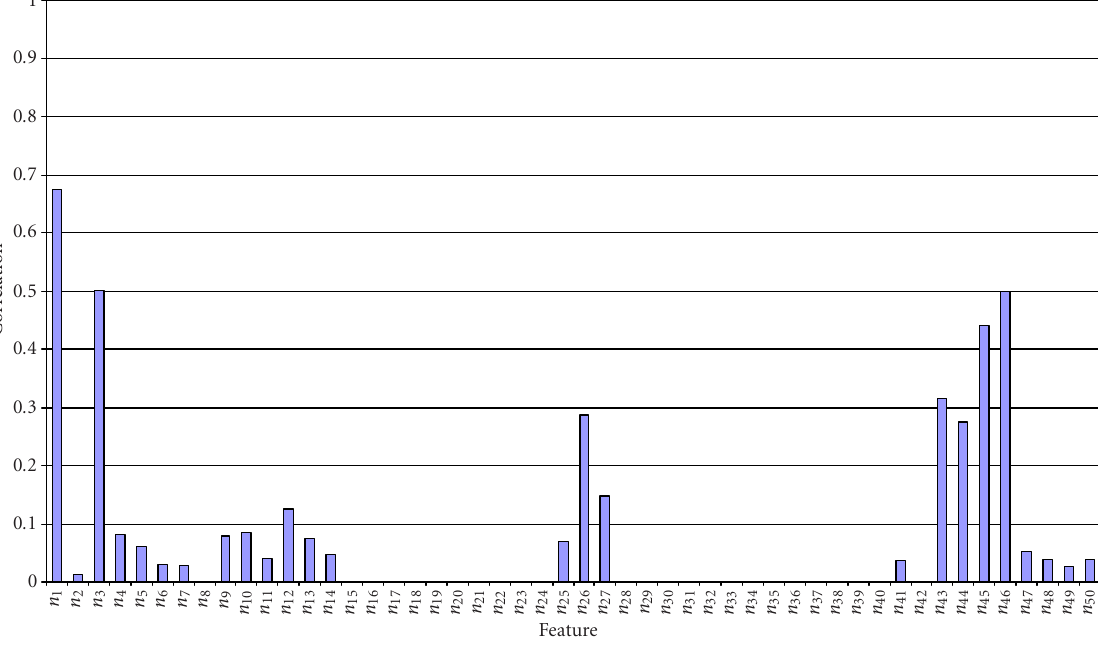
Figure 5: Feature stability and entropy